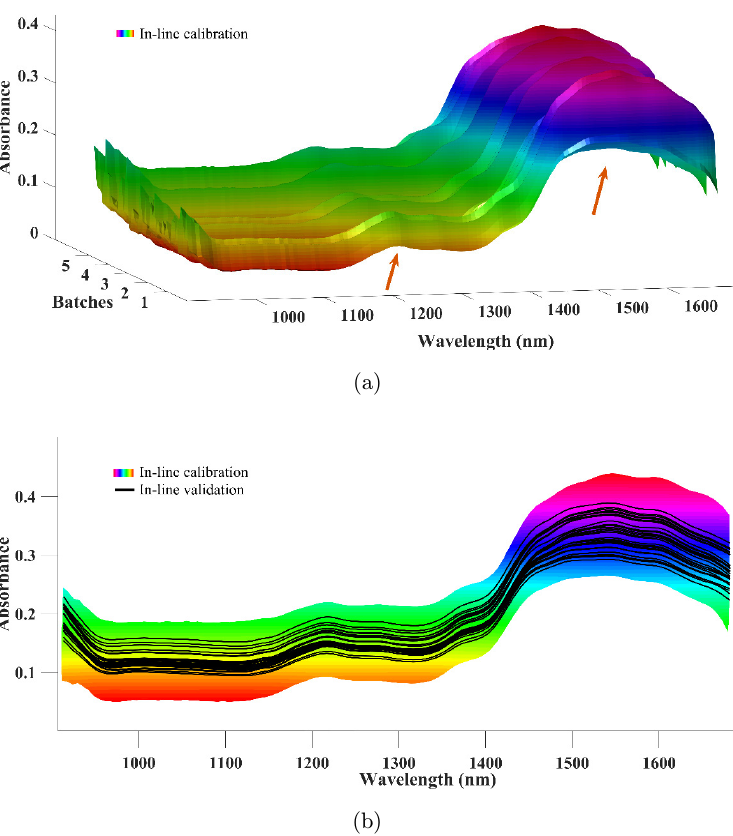
Fig. 2. (a) The raw spectra of the ¯ve granulation batches to establish the moisture content calibration model. (b) The raw spectra to establish the moisture content calibration model and the raw spectra of two granulation batches to validate the calibration